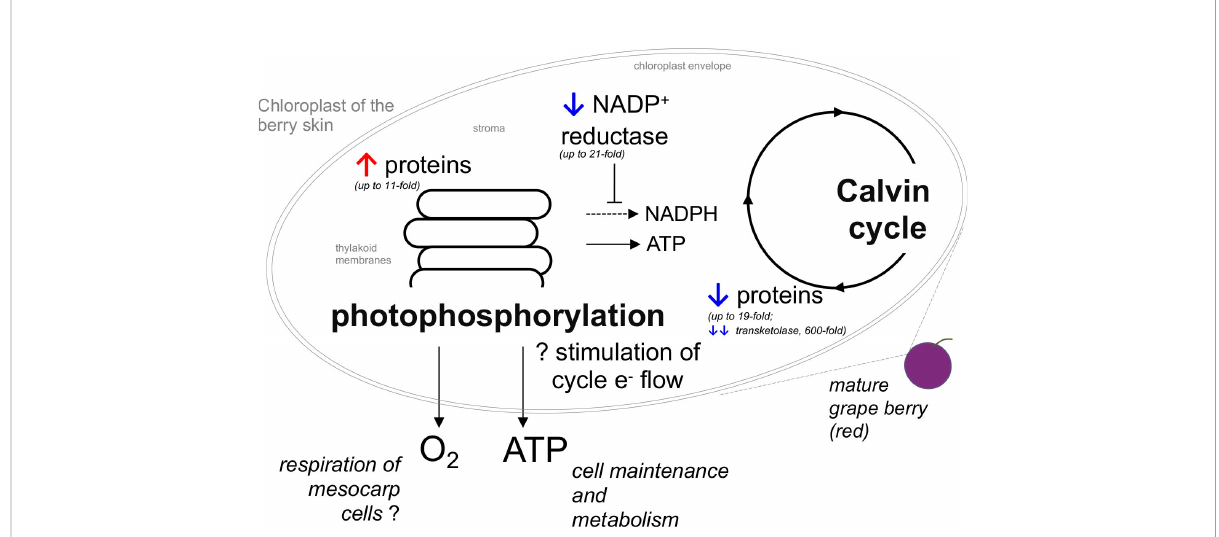
FIGURE 7 Illustration of the proposed changes in photosynthesis occurring in the chloroplasts of the skin of red grape berries during the transition from the green (E-L 34) to the mature stage (E-L 38). Blue and red arrows denote that the proteins are overrepresented ( ↑ ) or underrepresented ( ↓ ) at the mature stage when compared to the green